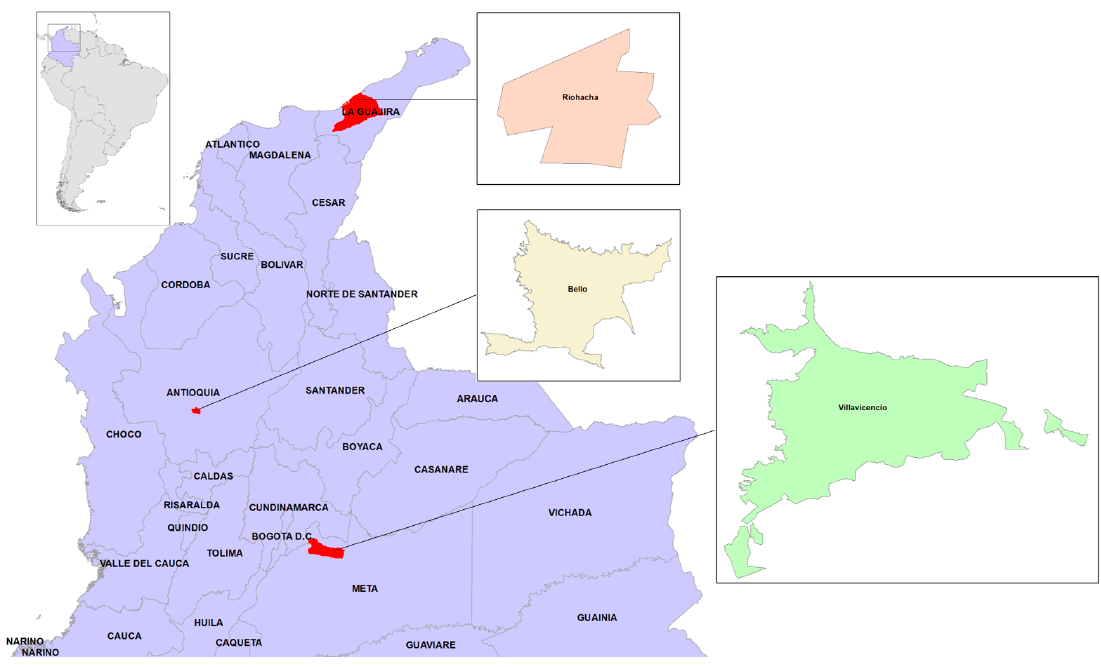
Figure 1. Geographic location of the three study cities in Colombia. The urbanized area of the cities is magnified.